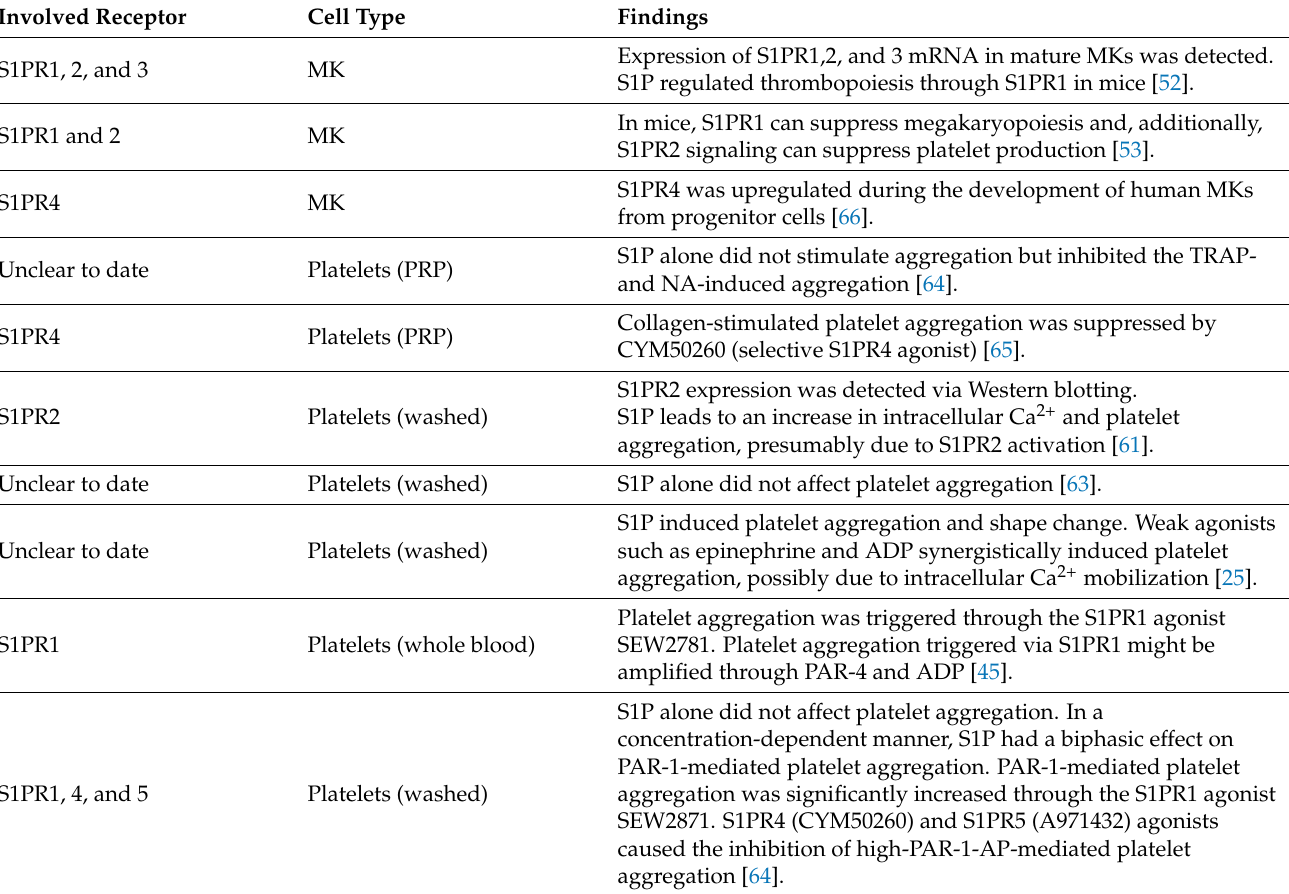
Table 1. Literature overview of the effects of S1P on platelets or megakaryocytes and the possible S1PR involved. ADP, adenosine diphosphate; AP, activating peptide; Ca 2+ , calcium; MK, megakaryocyte; NA, noradrenalin; PAR-4, protease-activated receptor 4; PPP, platelet-poor plasma; PRP, platelet- rich plasma, S1P, sphingosine-1-phosphate; S1PR, S1P receptor; TRAP,